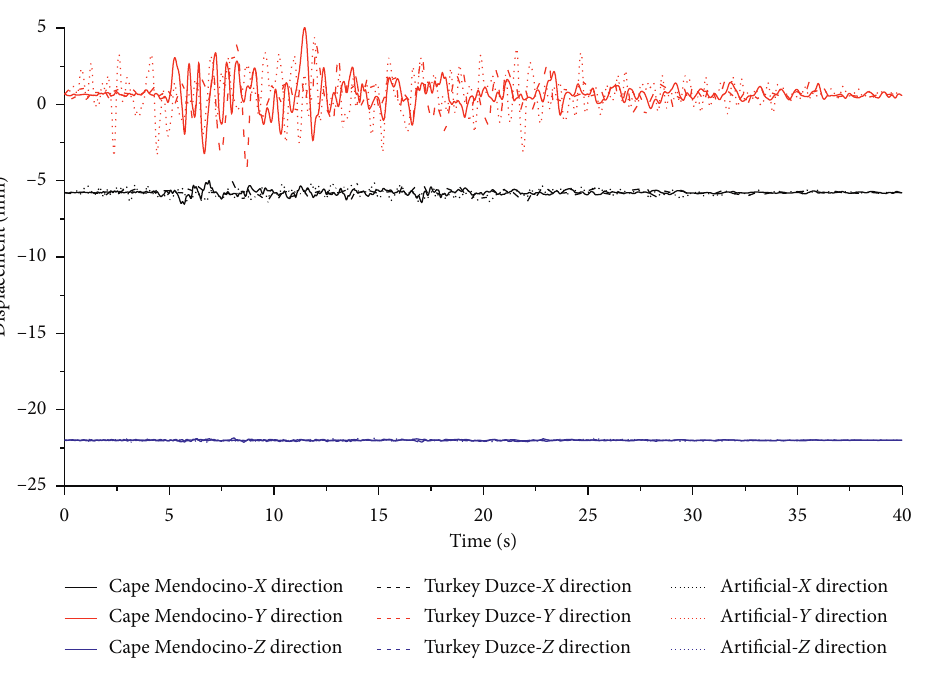
Figure 11: Displacement–time curves of climbing formwork without core tube under the construction